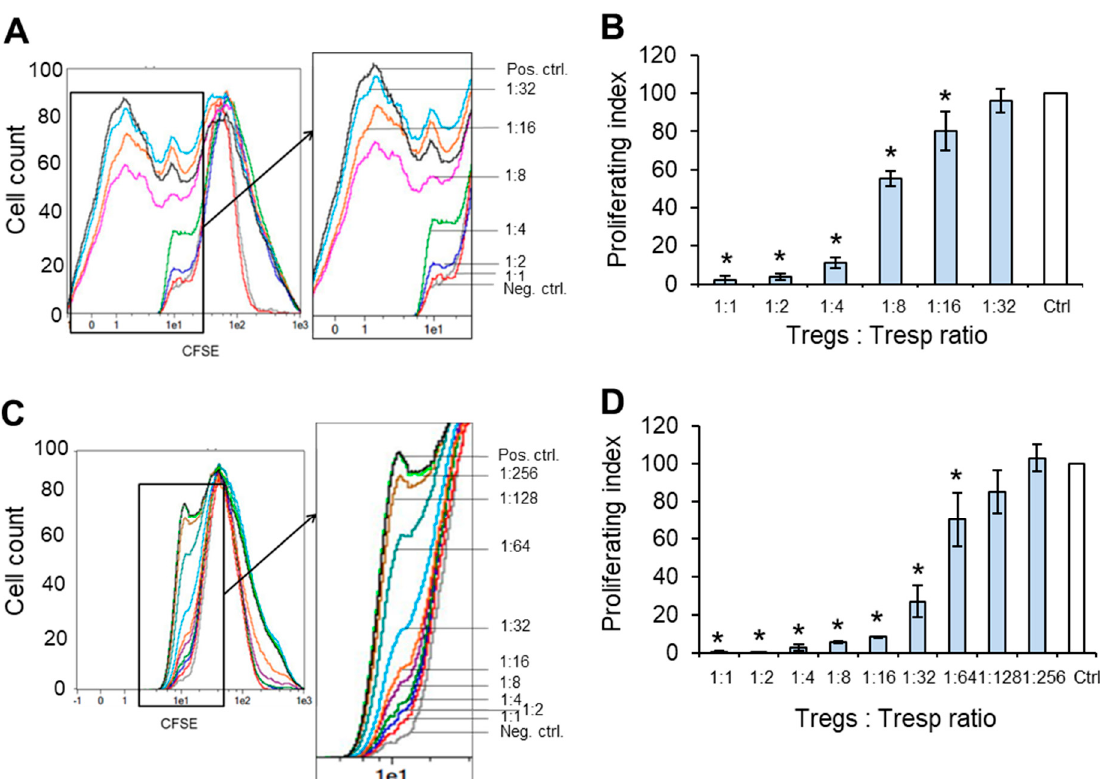
Figure 7. Enhanced suppressive activity of eTregs: Representative proliferative diagram of ( A ) pTregs and ( C ) eTregs. CFSE-labeled CD4 + CD25 – responder cells were cocultured with accessory cells and pTregs or eTregs at various ratios. Results are shown as the percentage of proliferated target cells measured by reduction of the CFSE signal using flow cytometry. Neg. ctrl—negative control, CD4 + CD25 - cells only. Pos. ctrl—positive control, CD4 + CD25 – cells cocultured with accessory cells. Proliferation index of CD4 + CD25 - responder cells cocultured with accessory cells and ( B ) pTregs and ( D ) eTregs at various ratios. Ctrl—control, CD4 + CD25 – cells cocultured with accessory cells. n = 5. * p ≤ 0.05 vs. control cells.